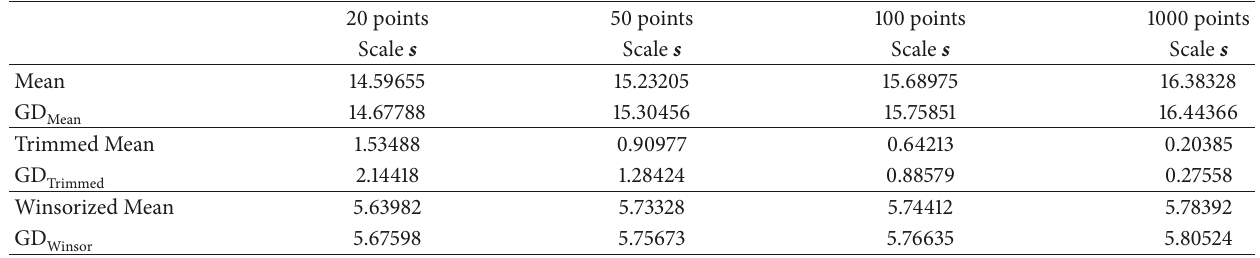
Table 5: This table reports the values of scale for a log normal distribution of parameters 𝑥 = 2 and 𝑠 = 1 and 30 % of Gaussian noise. The ideal value to obtain is 15.97. The level of noise is expressed as percentage of the mean of the distributions. In the columns we have the scale values when the distributions are composed with 20, 50, 100, and 1000 points.